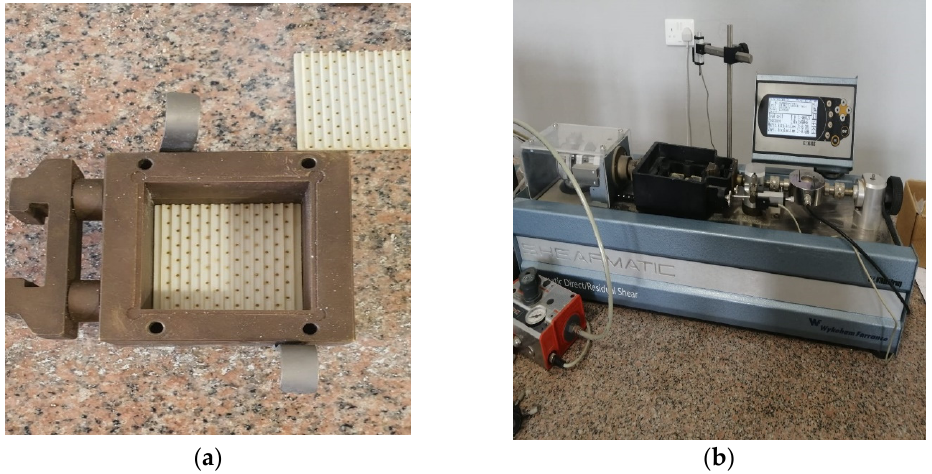
Figure 3. The shear strength device used in this study: ( a ) Shear box (60 mm × 60 mm cm × 20 mm). ( b ) Shear strength device.